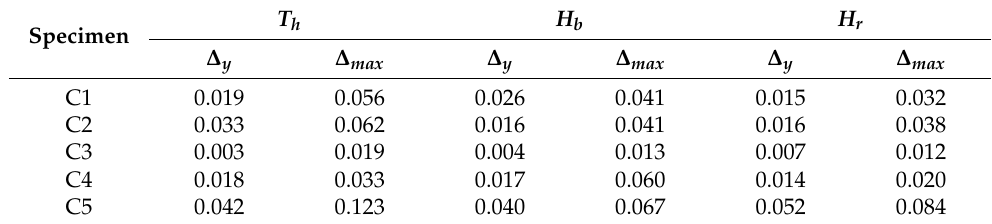
Table 3. Summary of recorded strain values at ∆ y and ∆ max